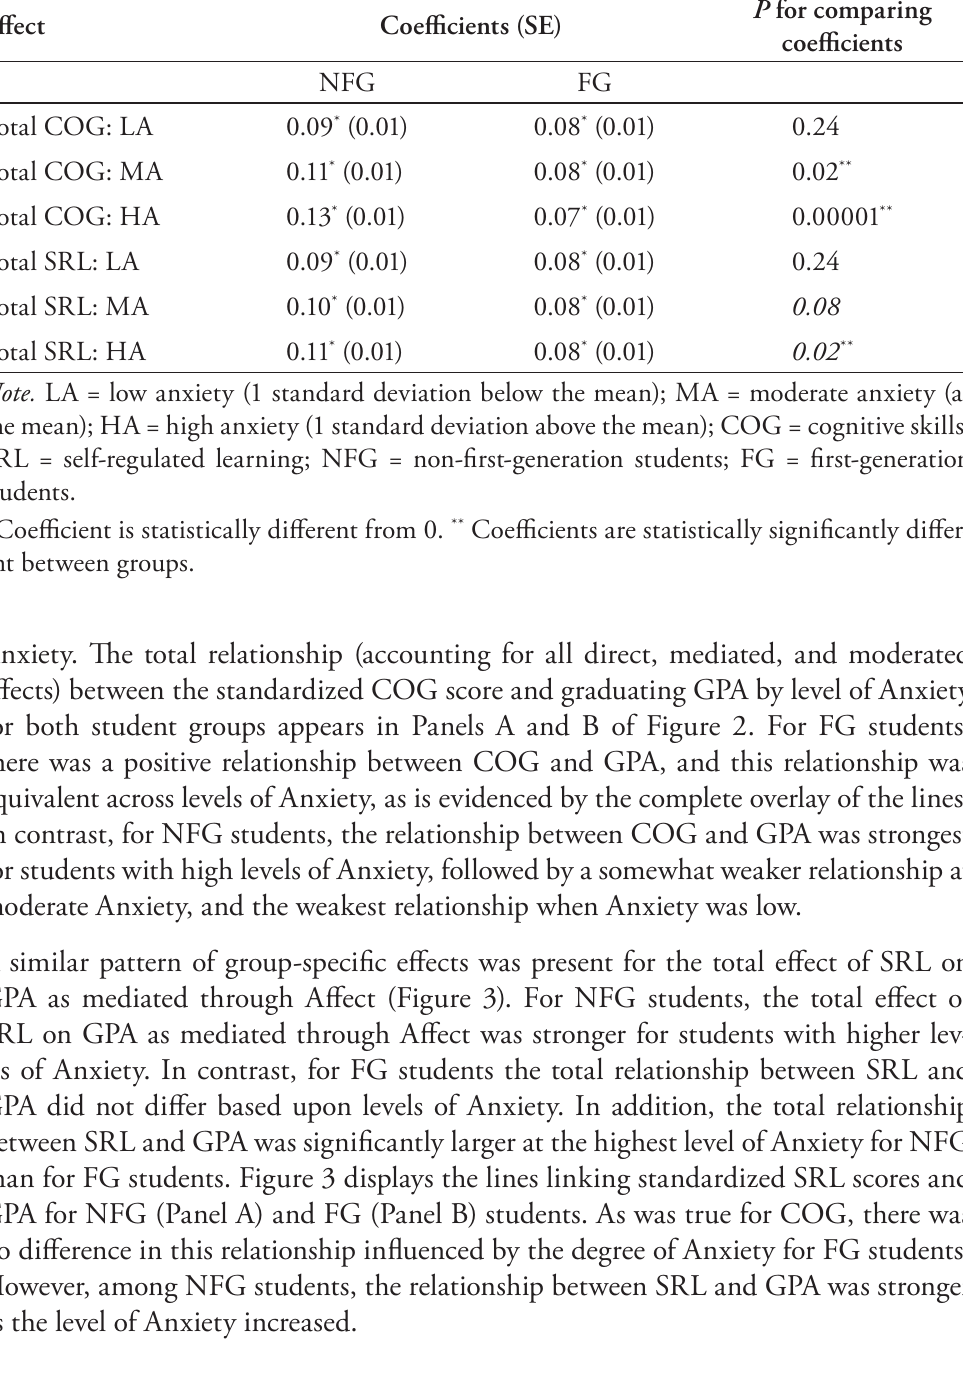
Table 4. Total Effects by Levels of Anxiety and First- Generation Status